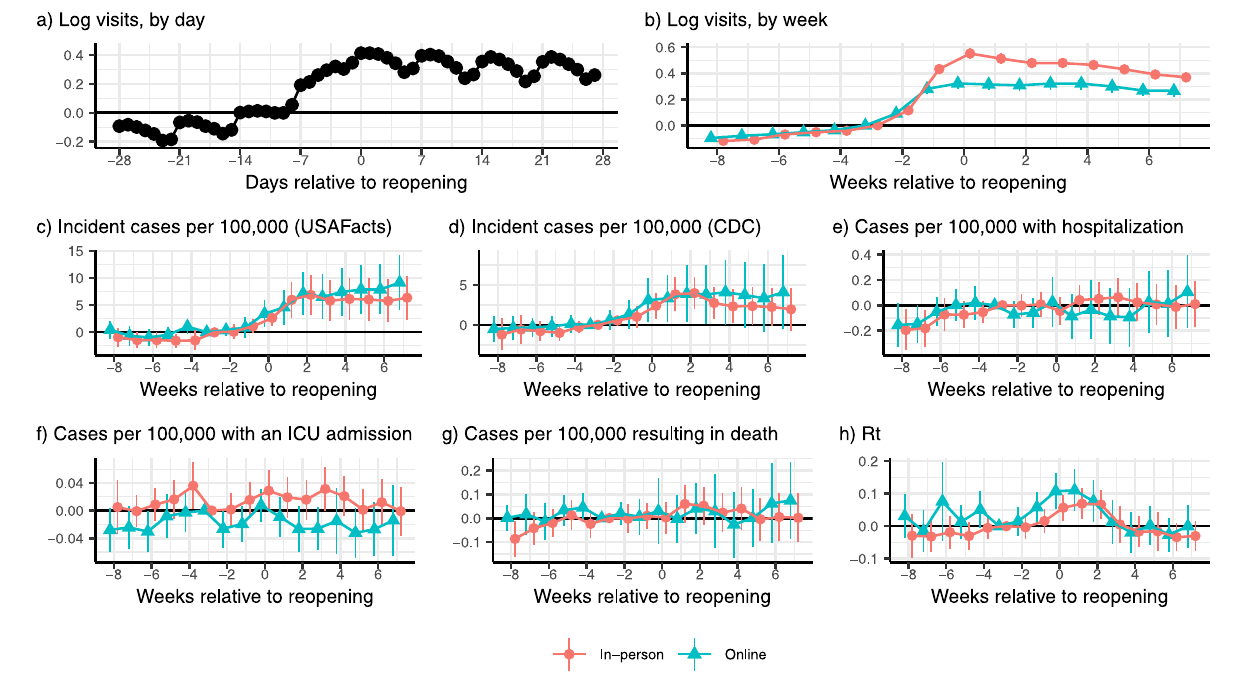
Fig 1. Event study estimates of reopening college campuses, relative to counties without a college campus. (a) Reopening college campuses significantly increased the number of devices on college campuses ( χ 2 (28) = 1355.79, p < 0.001). These increases persisted on college campuses (b) for at least eight weeks after reopening (In-person: χ 2 (8) = 791.03, p < 0.001; Online: χ 2 (8) = 249.37, p < 0.001) and were larger for campuses that reopened for primarily in-person teaching ( χ 2 (8) = 330.75, p < 0.001). Reopening college campuses also increased the incidence of COVID-19 in the county, regardless of teaching modality using data from USAFacts (c; In-person χ 2 (8) = 19.6, p = 0.012; Online χ 2 (8) = 18.8, p = 0.016) and for in- person teaching using data from the CDC (d; In-person χ 2 (8) = 18.5, p = 0.018; Online χ 2 (8) = 7.3, p = 0.507]). After reopening there were significantly more cases resulting in hospitalization (e) associated with in-person, as opposed to online, reopening ( χ 2 (8) = 17.1, p = 0.029). However, there were no significant differences in ICU utilization (f, χ 2 (8) = 10.8, p = 0.215) in the first eight weeks after reopening. During the first eight weeks, in-person teaching was not associated with a greater incidence of mortality, relative to online teaching ( χ 2 (4) = 13.8, p = 0.086). Local transmission (h), measured by R t , was significantly different from zero after reopening a college, regardless of teaching modality (In-person χ 2 (8) = 40.4, p < 0.001; Online χ 2 (8) = 37.3, p < 0.001). COVID-19 related data are from the CDC unless otherwise